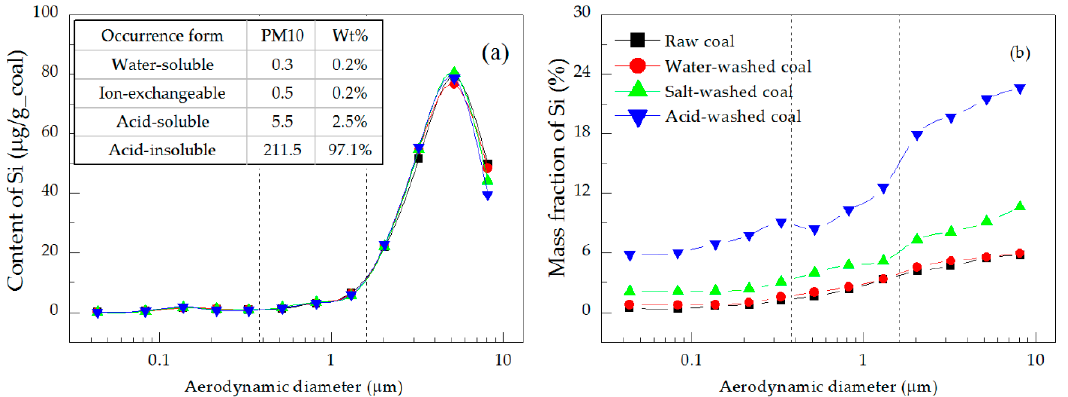
Figure 9. Distributions of the ( a ) content and ( b ) mass fraction of Si in the PM.